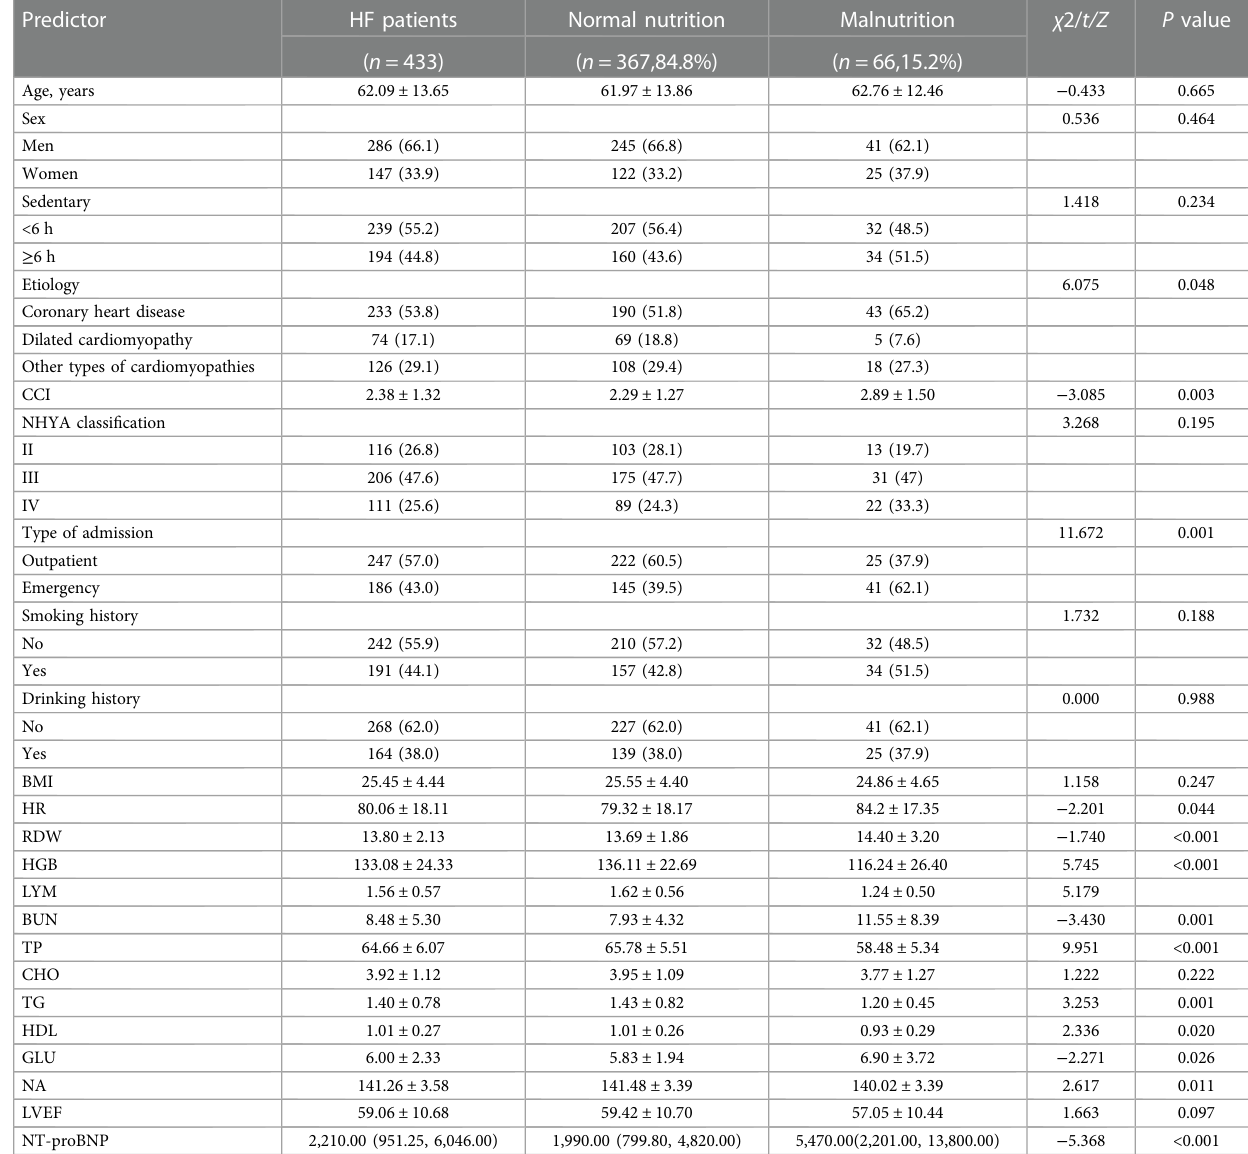
TABLE 1 Univariate analysis of the malnutrition in patients with heart failure. Predictor HF patients Normal nutrition